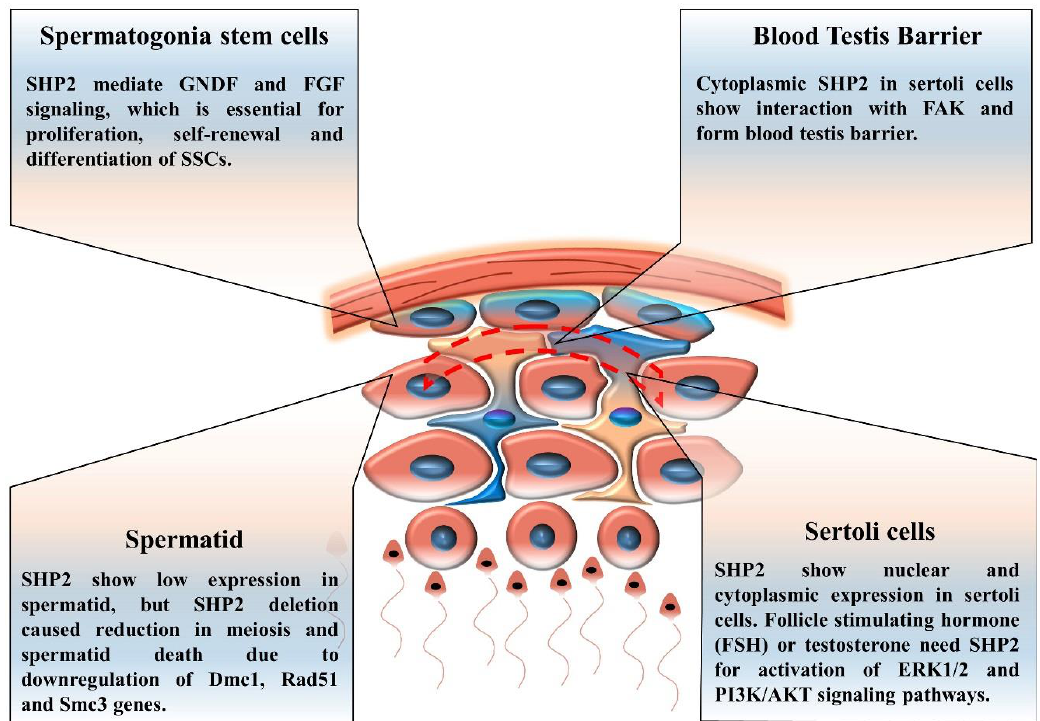
Figure 4. Scheme depicting the generation of mature sperm from spermatogonia stem cells and the key pathways involved. SHP2 expression in sertoli cells, spermatogonia stem cells, and involvement of SHP2 in blood–testis barrier formation. SHP2 also show nuclear localization in sertoli cells, but the function is unknown.